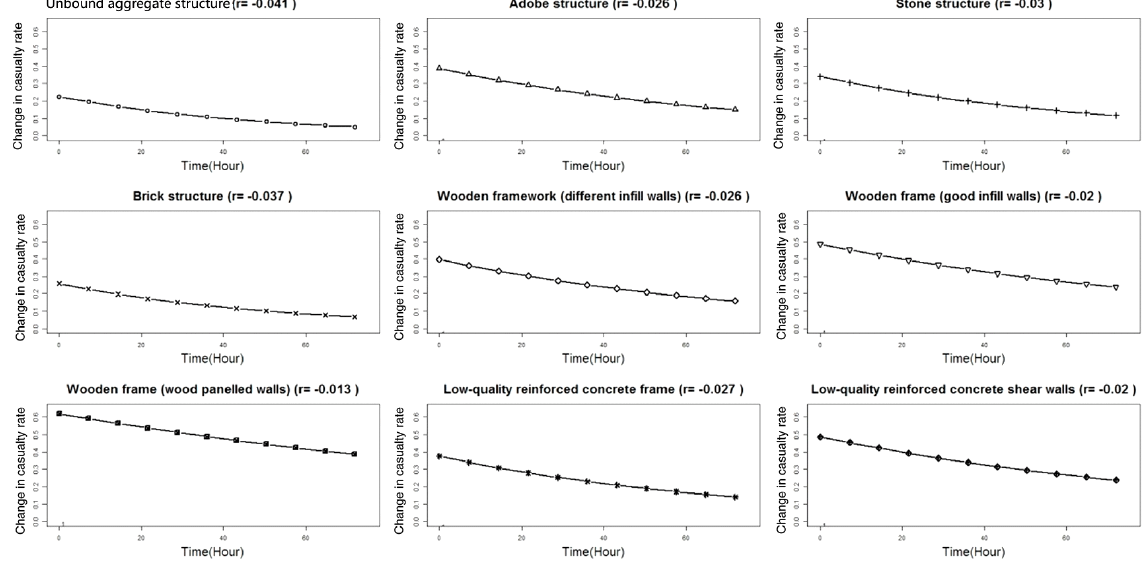
Figure 7. Change in the survival rate of different buildings in a collapsed state.